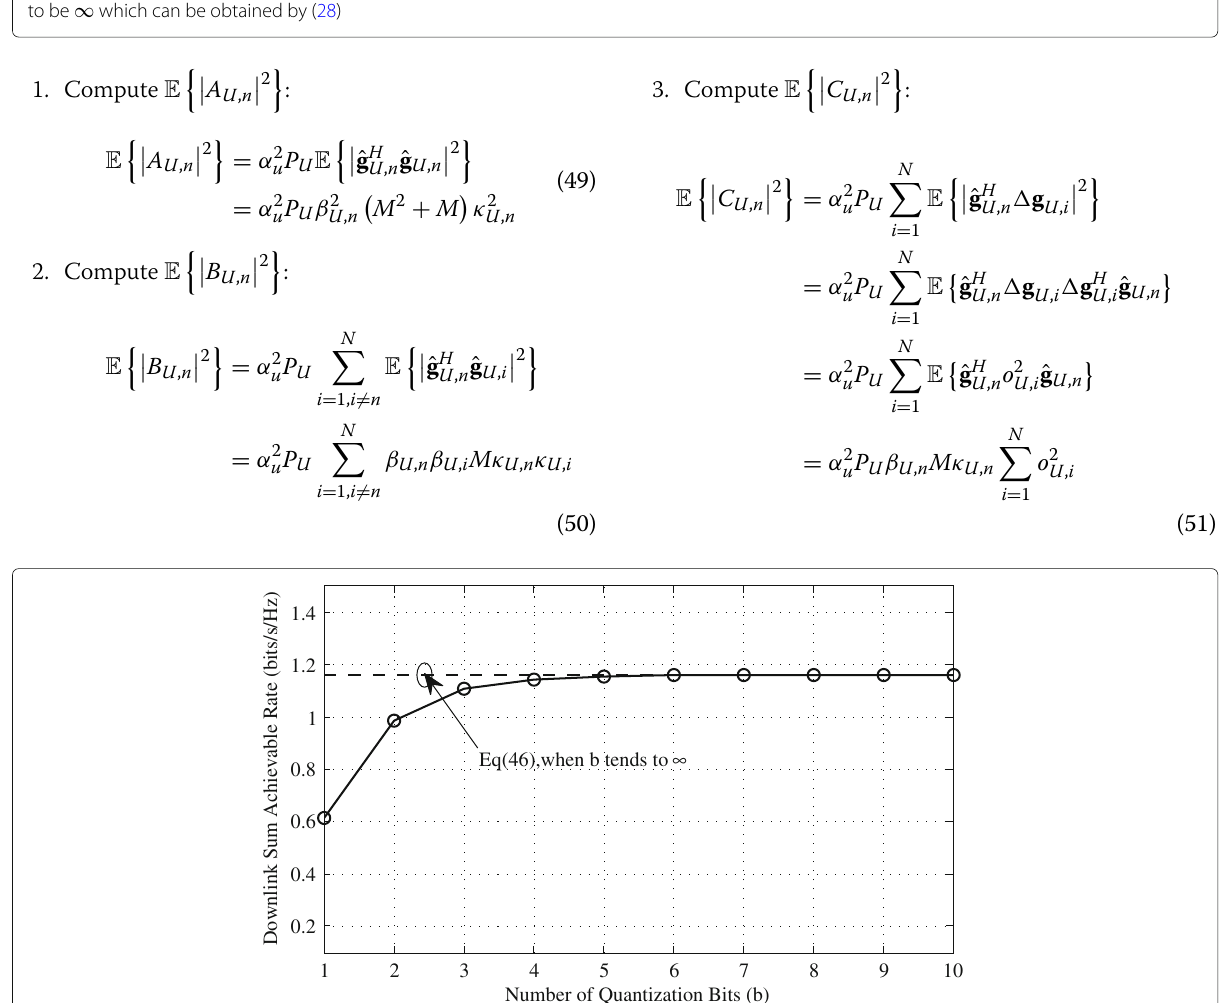
Fig. 5 Downlink sum achievable rate when b tends to be ∞ . Description of downlink sum rate for the different numbers of quantization bits b and b tends to be ∞ which can be obtained by